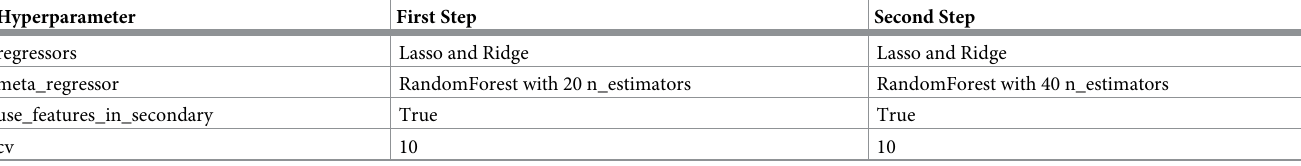
Table 6. Hyperparameters used by the stackingcvregressor model.